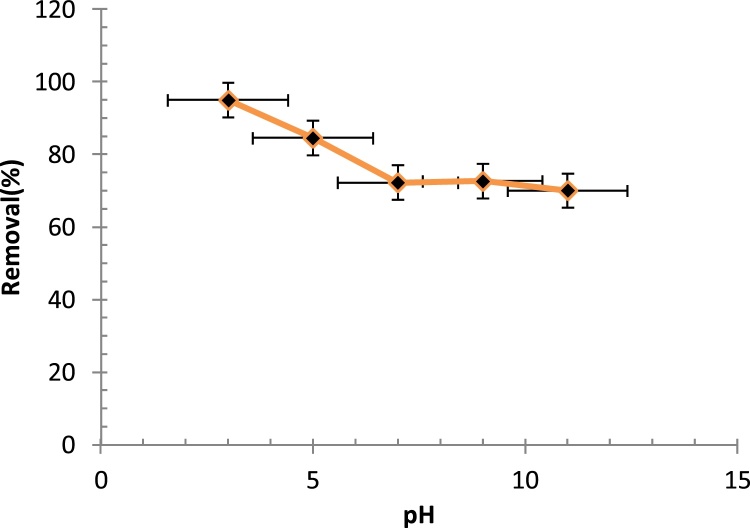
Effect of pH on the removal efficiency of aniline (Contact time: 60 min, H2O2 concentration: 0.01 mol/L, aniline concentration: 60 mg/L).